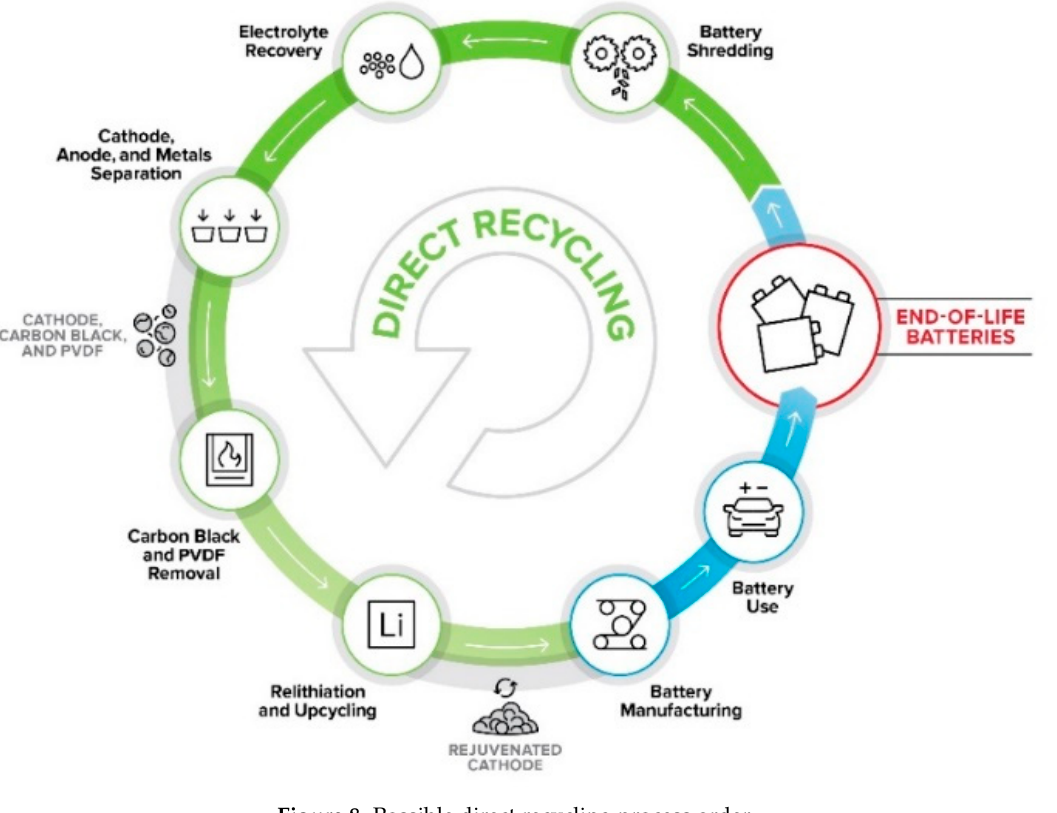
Figure 8. Possible direct recycling process order.